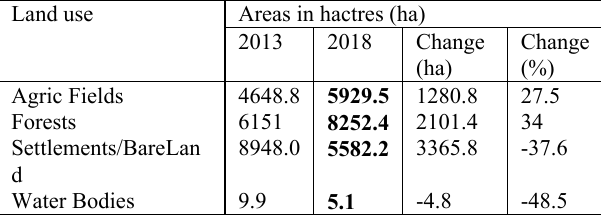
Table 1. Land cover change 1998-2004